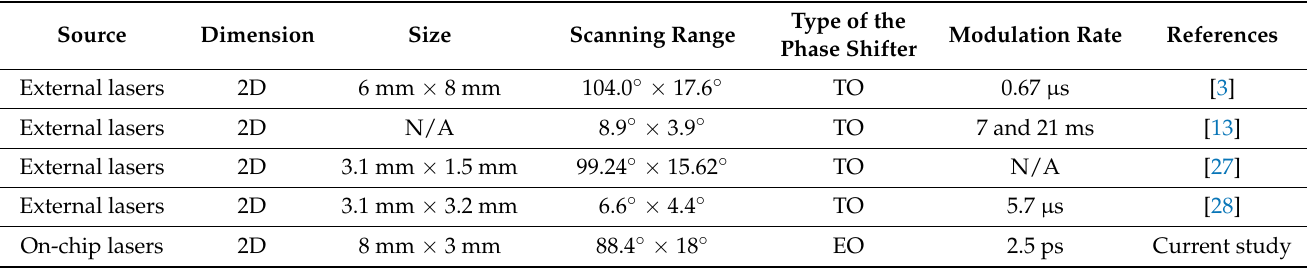
Table 3. Comparison of